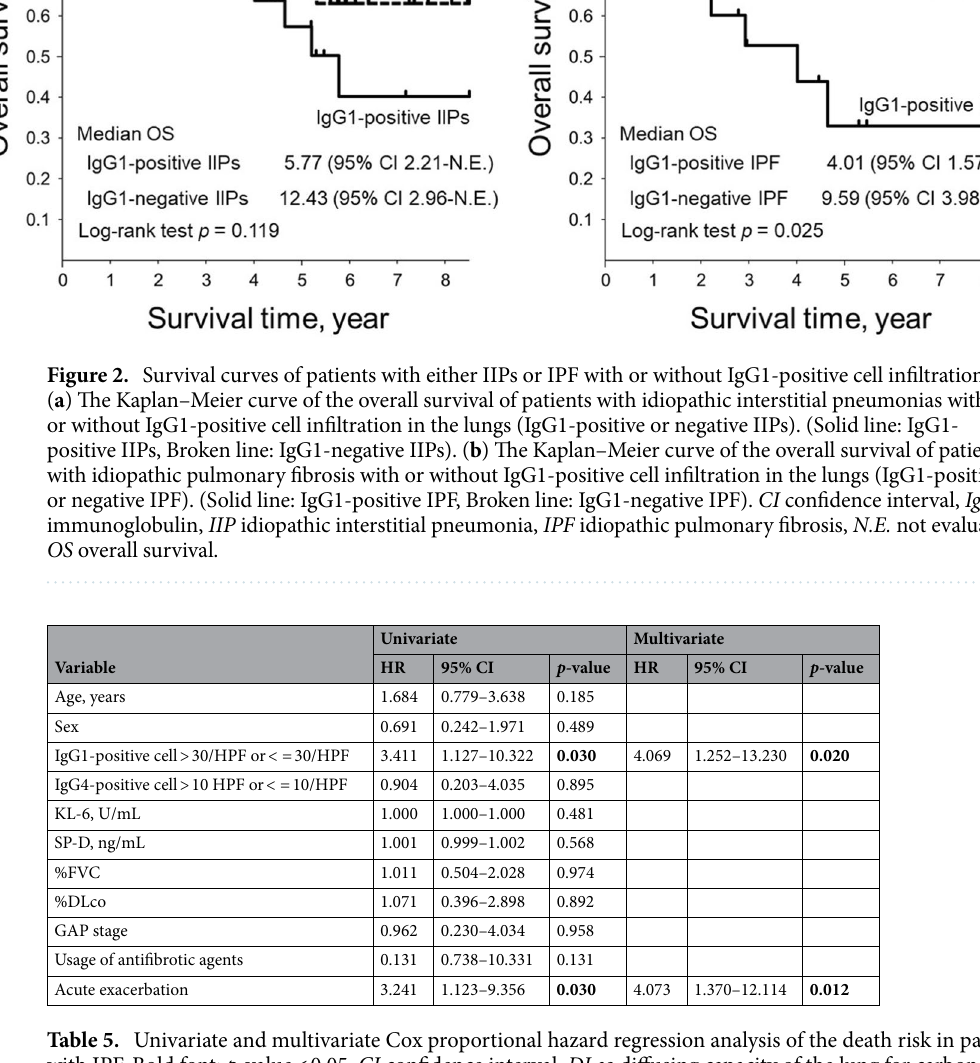
Table 5. Univariate and multivariate Cox proportional hazard regression analysis of the death risk in patients with IPF. Bold font: p -value < 0.05. CI confidence interval, DLco diffusing capacity of the lung for carbon monoxide, FVC forced vital capacity, GAP gender, age, physiological variable, HPF high-power field, HR hazard ratio, Ig immunoglobulin, IPF idiopathic pulmonary fibrosis, KL-6 Krebs von Lungen-6, SP surfactant protein.